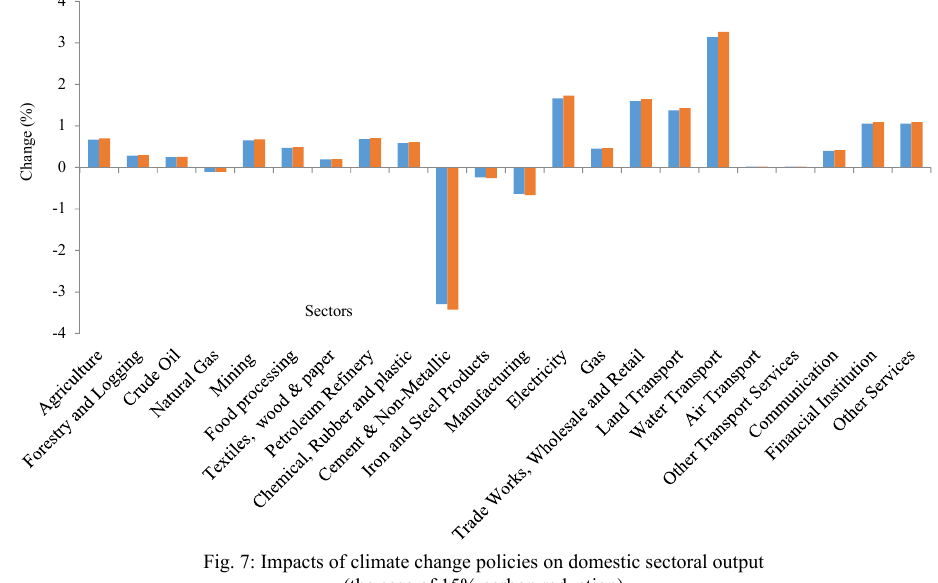
Fig. 7: Impacts of climate change policies on domestic sectoral output (the case of 15% carbon reduction)